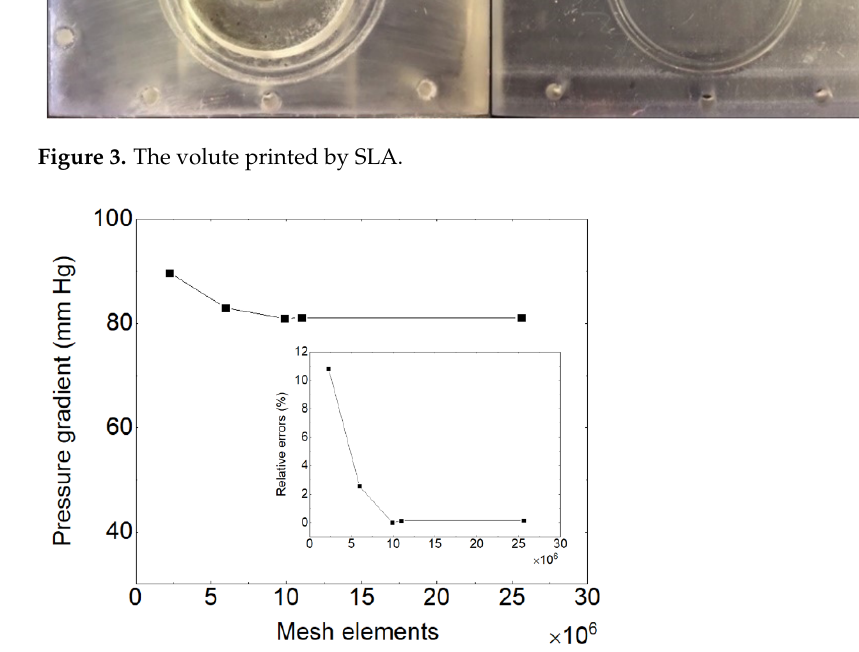
Figure 4. Mesh independence study of di ff erent mesh sizes on pressure gradient for the pump with impeller SH1 at the fl ow rate of 0.5 L/min and rotational speed of 2900 rpm.